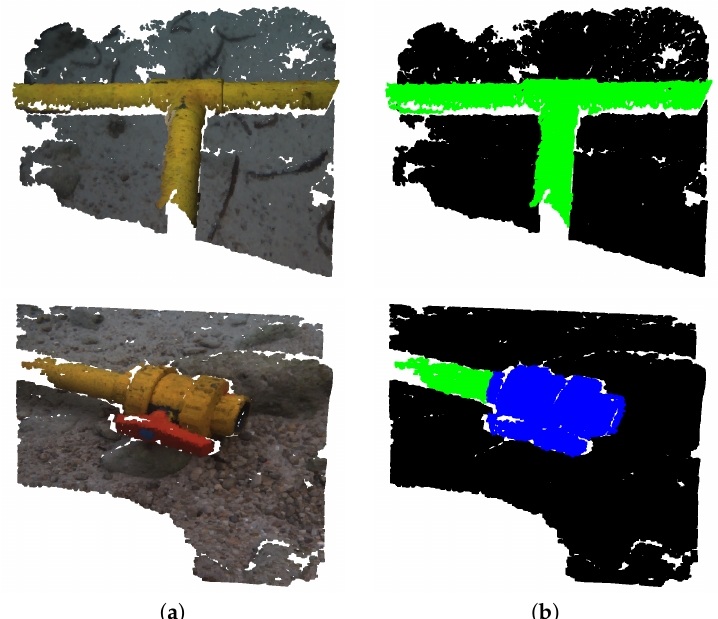
Figure 3. ( a ) Original point cloud; ( b ) ground truth annotations, points corresponding to pipes are marked in green; to valves, in blue; and to background, in